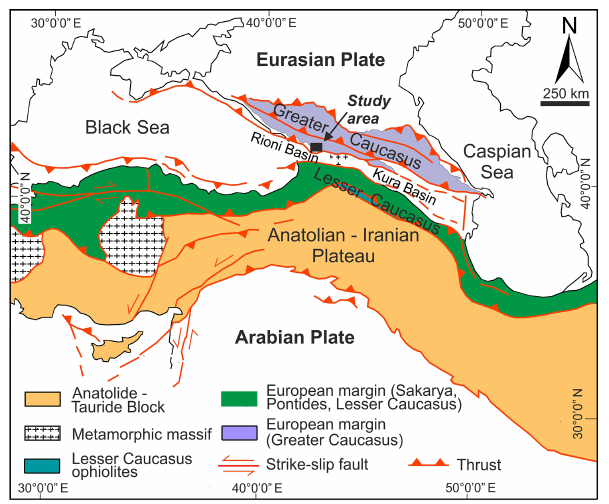
Figure 1. Tectonic map of the Arabia–Eurasia collision zone (mod- ified from Sosson et al., 2010).